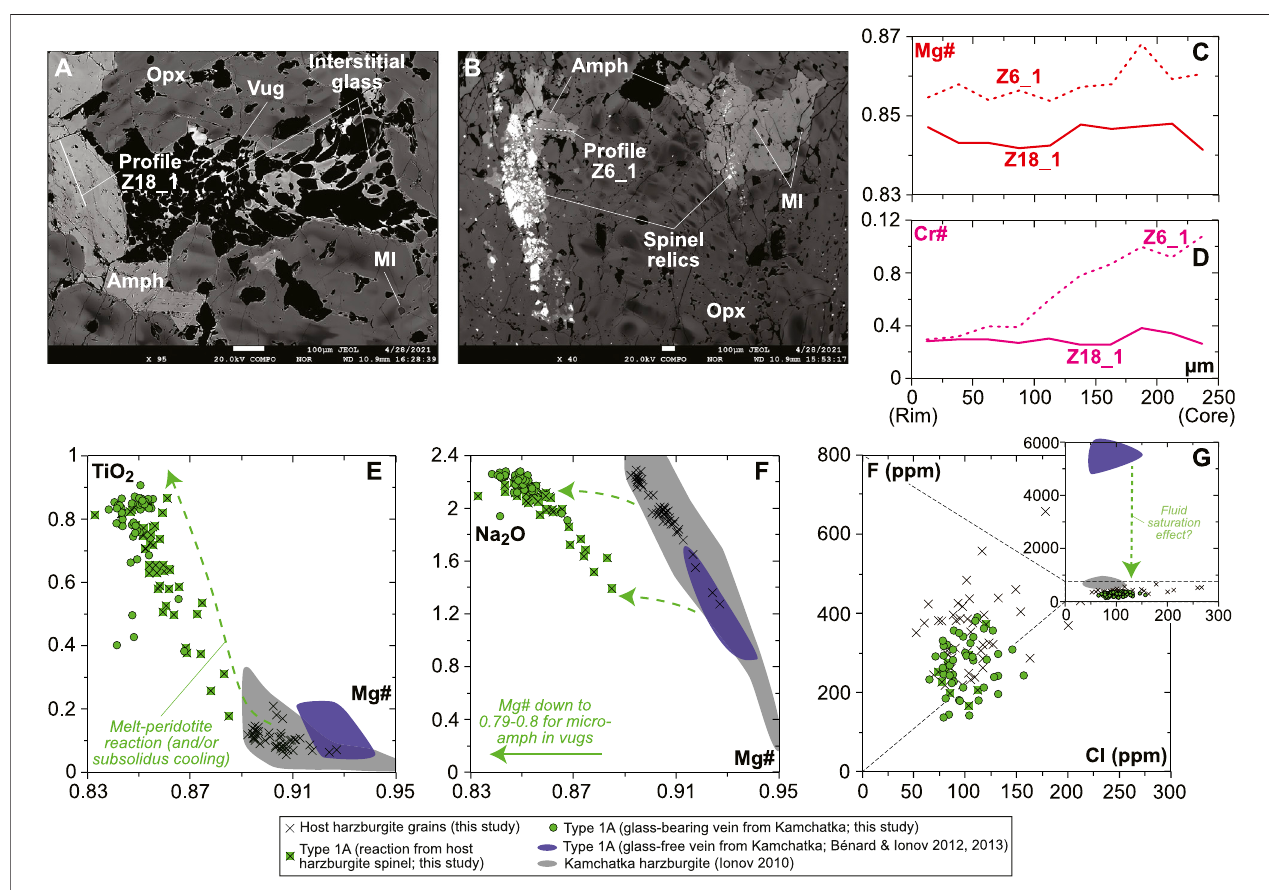
FIGURE 5 | Core-to-rim pro fi les and compositions for amphibole for the new Kamchatka sample in this study. (A,B) BSE images (EPMA) showing variable texture of (A) euhedral and (B) anhedral (i.e., replacing coarse spinel from the host harzburgite) vein amphibole. Scale bar is 100 μ m. (C) Mg# and (D) Cr# variations for the pro fi lesin (A,B) ,withsolidanddashedlines,respectively,referringtoeuhedralandanhedral(replacing)amphiboles. (E – G) Majorelement(inwt%foroxides)andhalogen compositions of all vein amphibole grain types. Note that euhedral grains occur in the glassy central part of the vein, on the contrary to anhedral (replacing) grains.